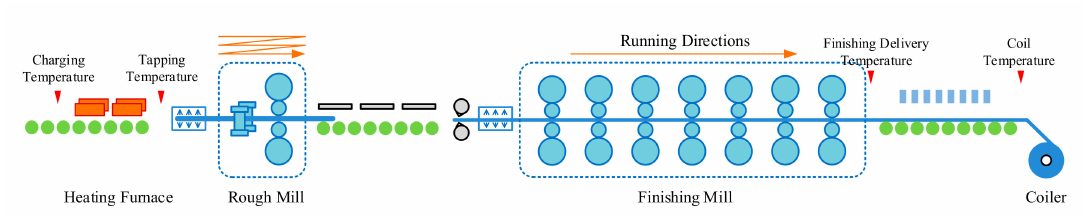
Figure 1. Layout of the typical traditional hot rolling